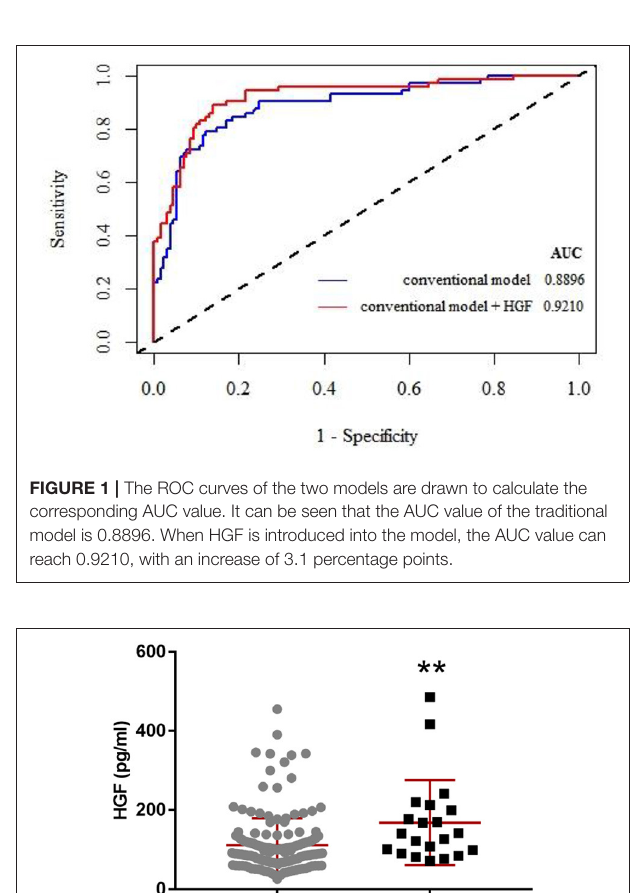
The optimal cutoff values are shown in Table 2 .